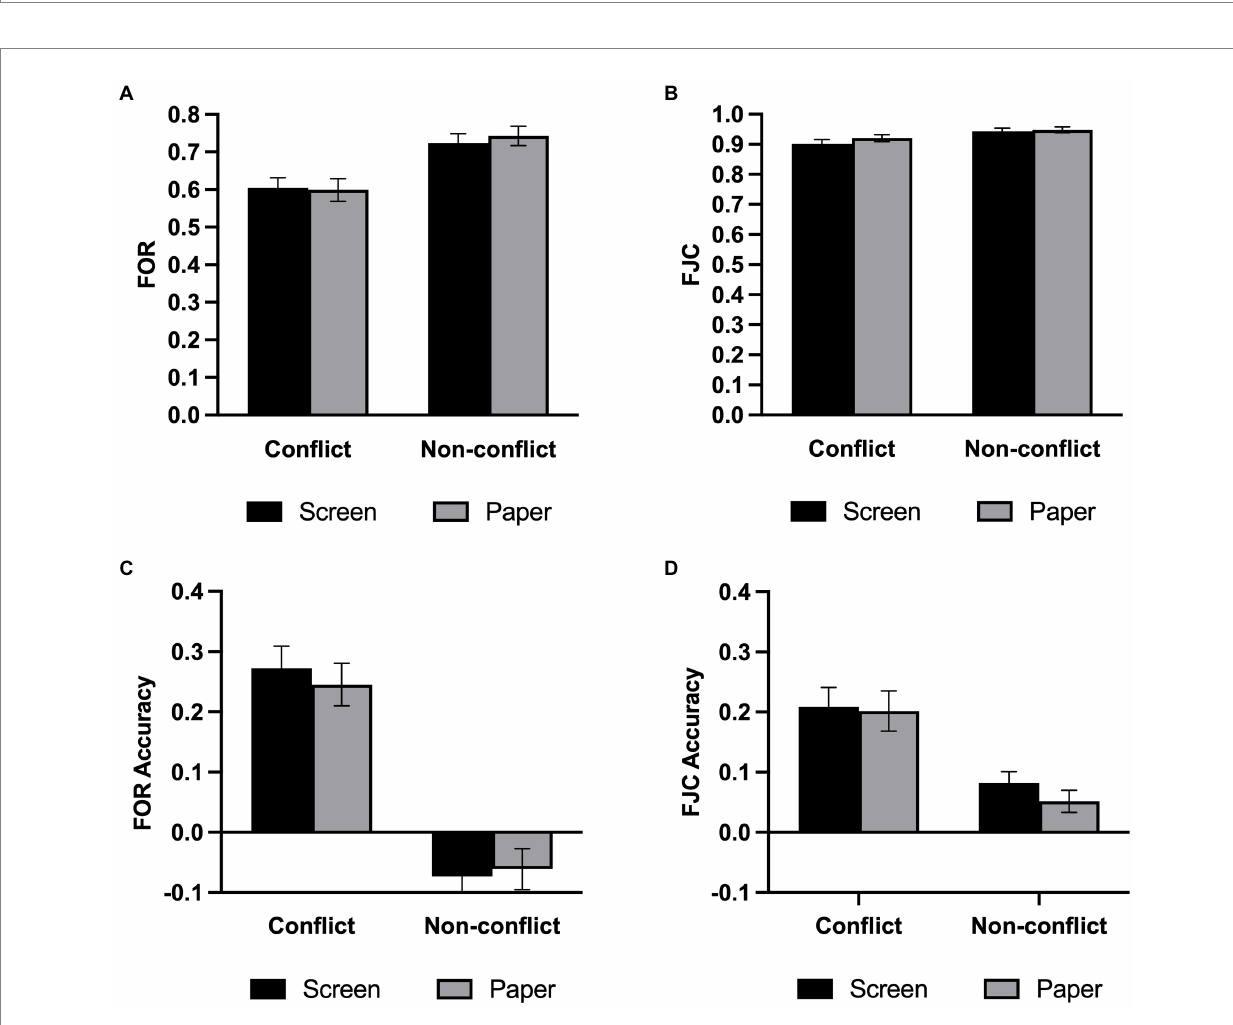
FIGURE 5 Meta-reasoning performance in Experiment 2. (A) FOR. (B) FOR accuracy. (C) FJC. (D) FJC accuracy. Error bars represent the standard error of the mean. *** p <